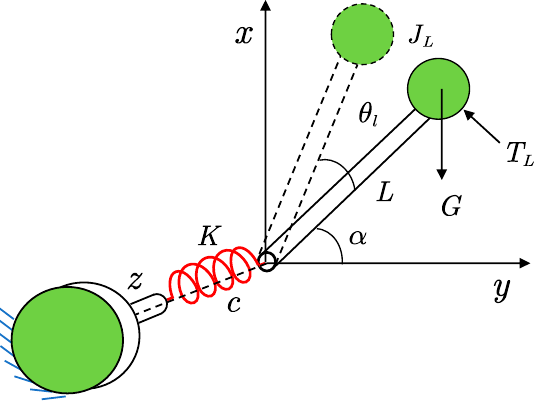
Figure 4. The single-degree-of-freedom oscillation system.